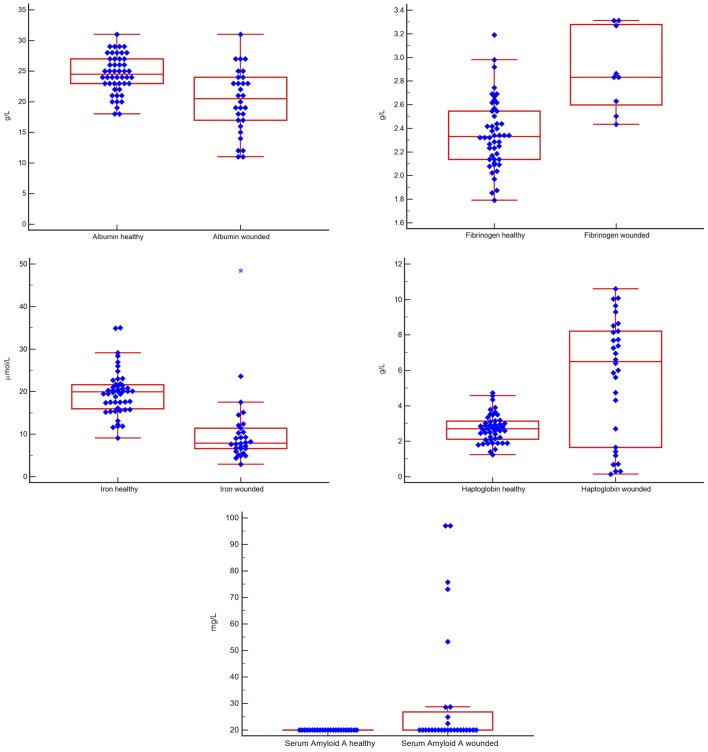
Box-and-whisker plots comparing results for five acute phase reactants in groups of healthy vs. injured white rhinoceros (Ceratotherium simum simum). The blue diamonds indicate individual values, the central red box indicates the interquartile range, the central horizontal red line indicates the median, the outside horizontal red lines indicate minimum and maximum excluding “far out” values. A blue star represents a “far out” result (smaller/ larger than the lower/ upper quartile plus 3 times the interquartile range). There were significant differences (p < 0.0047) between the two groups for all measurands.